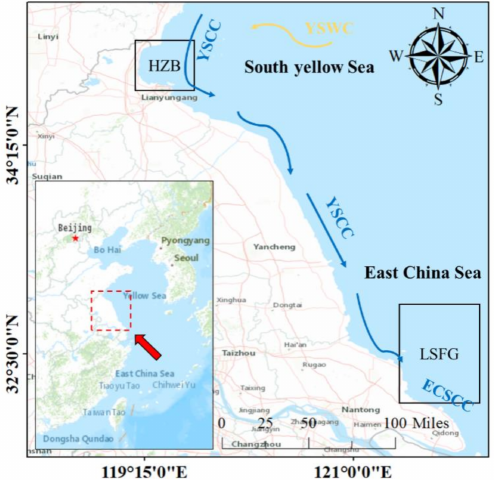
Figure 1. Modelled areas in the adjacent water of HZB (Haizhou Bay) and LSFG (Lvsi Fishing Ground). YSWC is the Yellow Sea Warm Current, YSCC is the Yellow Sea Coastal Current and ECSCC is the East China Sea Coastal